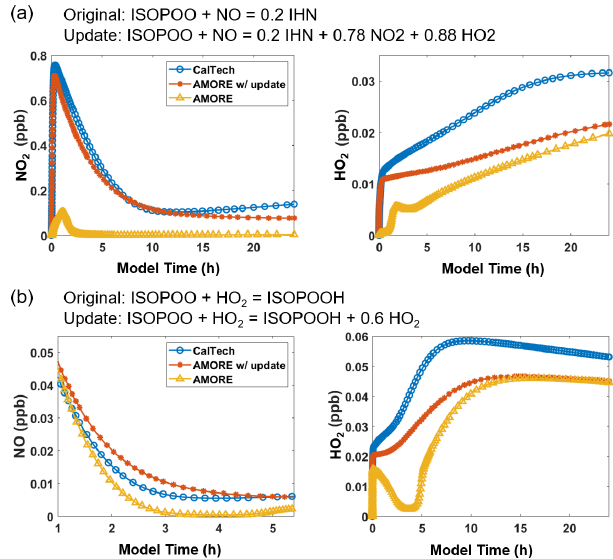
Figure 3. Box model simulations ( T = 292K, p = 1000hPa) showing the improvement in performance of the AMORE mecha- nism for HO 2 and NO x after adding these species to the products of Reactions (R4) (b) and (R5) (a) . The original and updated reactions are shown above the plots. Inputs are (a) 200ppb H 2 O 2 , 1ppb NO, 10ppb isoprene, and moderate-photolysis conditions (F0AM pho- tolysis parameter = 1) and (b) 200ppb H 2 O 2 , 1ppb NO, 10ppb isoprene, and high-photolysis conditions (F0AM photolysis param- eter =